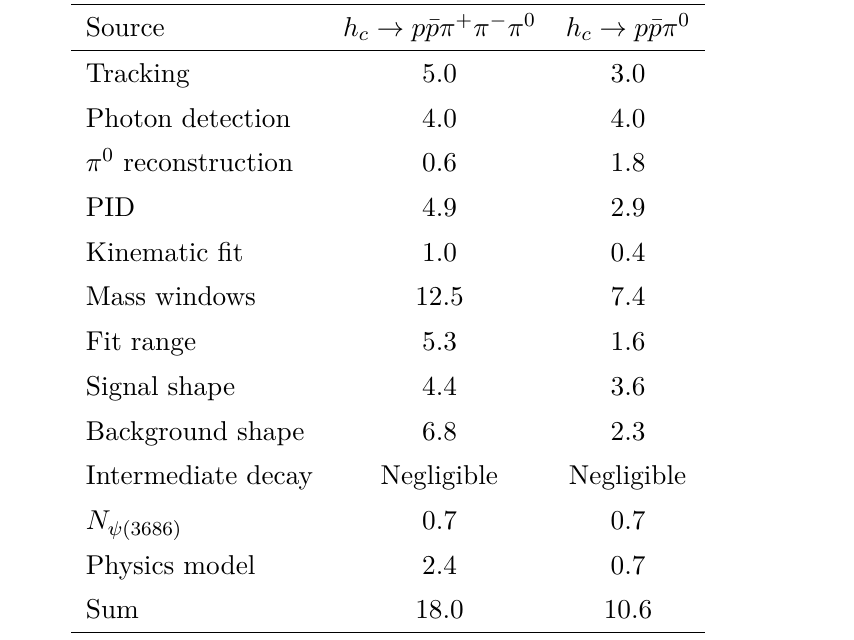
Table 4 . The relative systematic uncertainties for the h c → p ¯ pπ + π − π 0 , p ¯ pπ 0 decay channels (in % ).